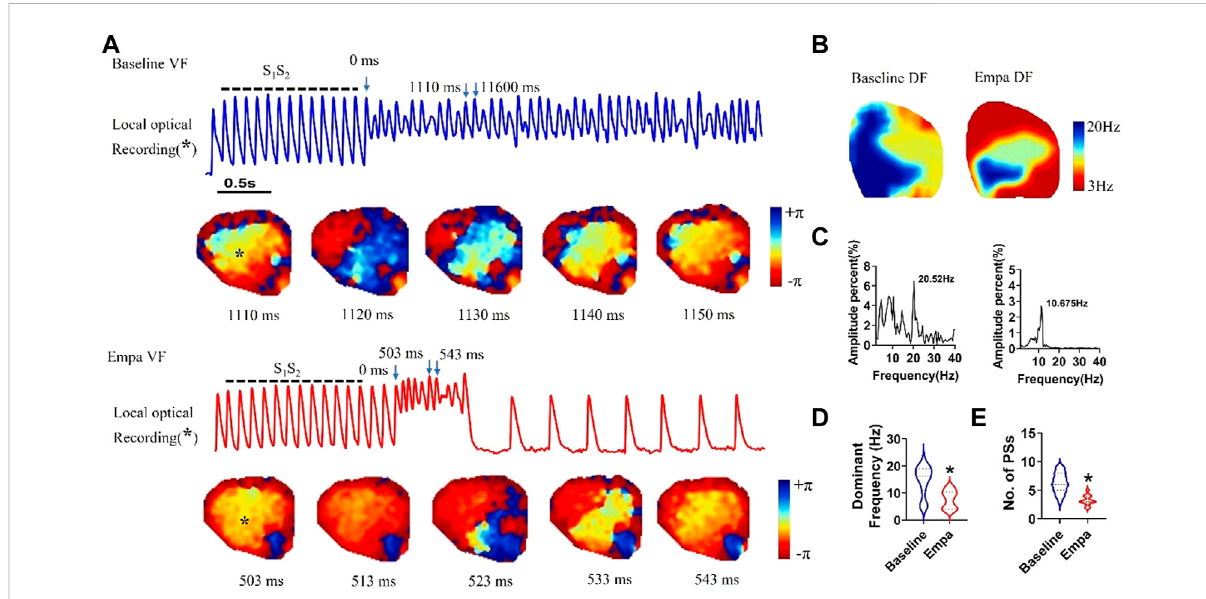
FIGURE 8 Effects of EMPA on the wave breaks and dominant frequency of ventricular fi brillation in infarcted ventricles. (A) Recordings of S1S2 pacing- inducedsustainedVFepisodesatbaselineandafterEMPAinfusioninaninfarctedventricle.Top,correspondingopticalrecordingofVFattheasterisk site. Consecutive phase maps sampled at 10 ms intervals during VF at baseline and after EMPA infusion. (B – D) DF distribution of VF at baseline and after EMPA infusion. N = 10 mice. * p < 0.05 versus baseline. (E) Effects of EMPA on the number of phase singularities before and after EMPA infusion in infarcted ventricles. Note that the numbers of phase singularity are decreased by EMPA. N = 10 mice. * p < 0.05 versus baseline. p -values were determined using an unpaired t test.